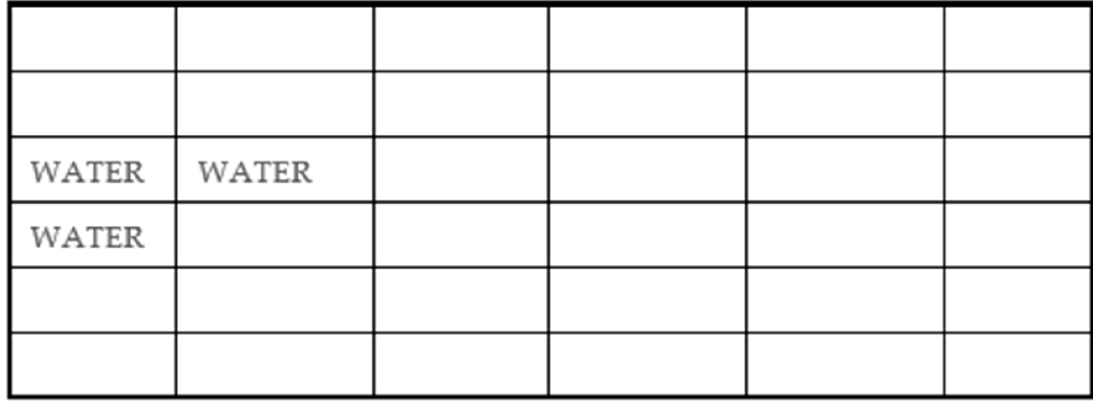
Figure 6. Working Navigation Map WNM’ <x> —what action should occur? (Equation (87)).